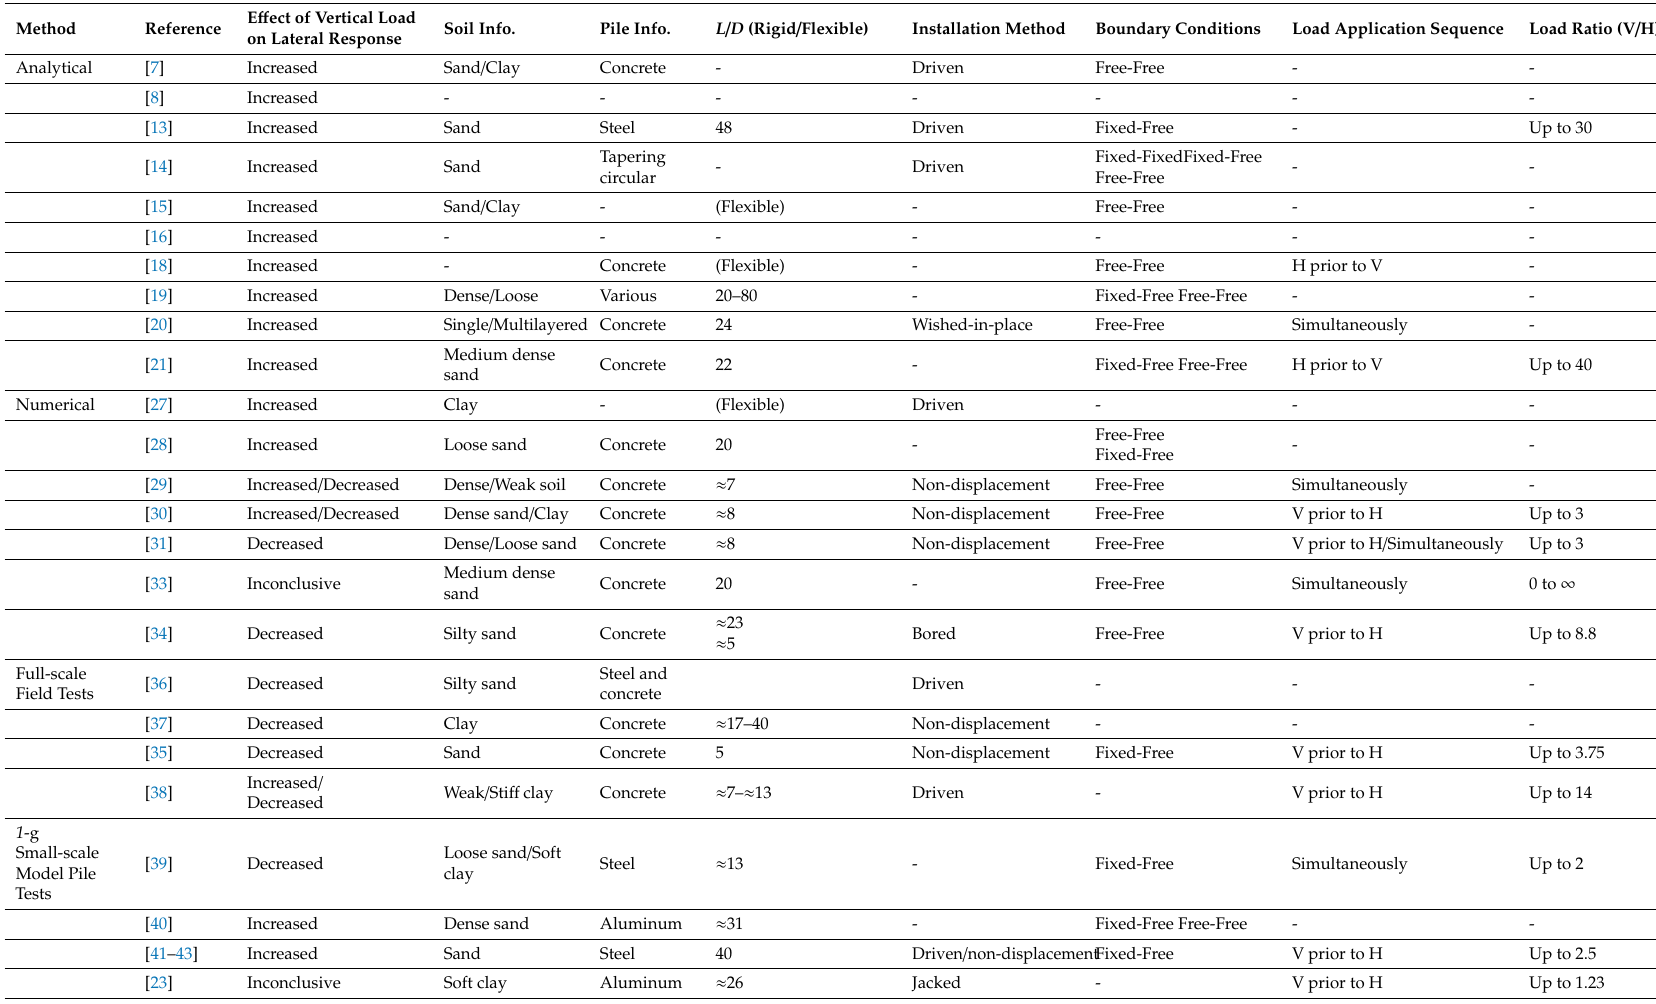
Table 1. Summary of research